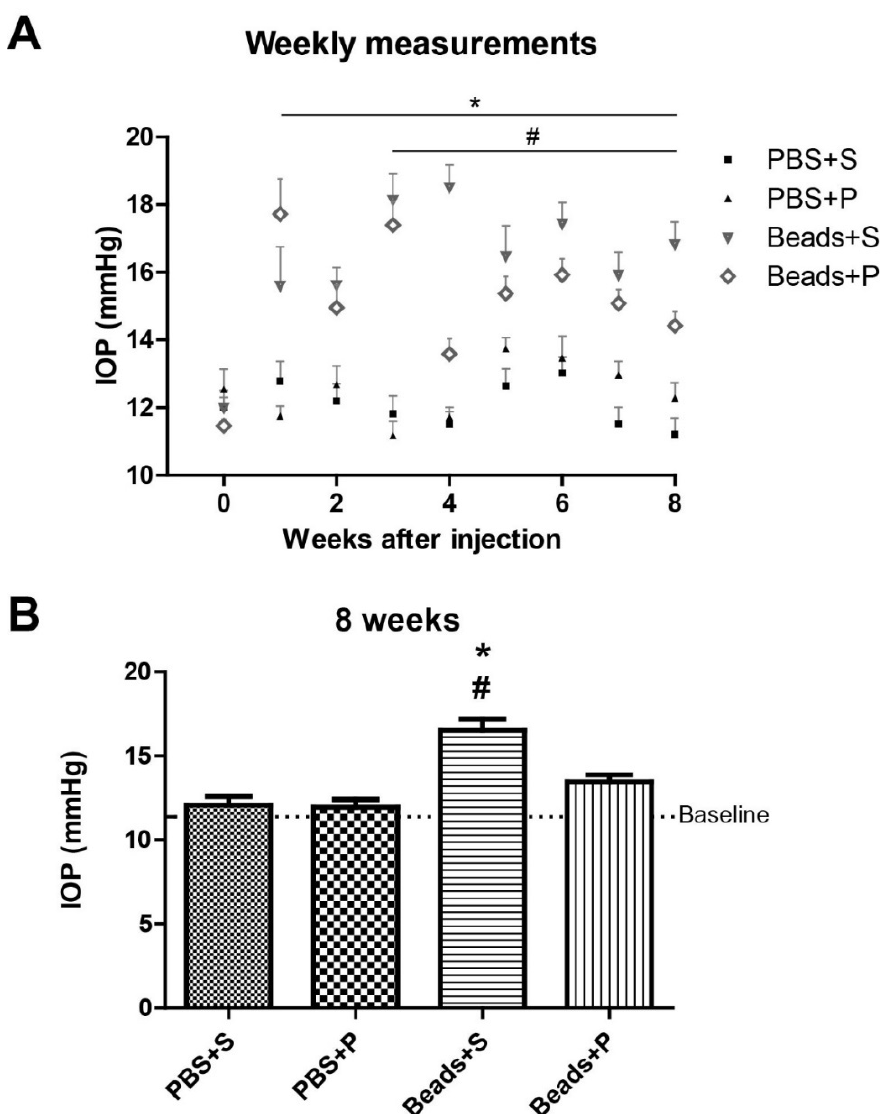
Figure 1. ( A ). IOP dynamics in the four examined groups (PBS + S, PBS + P, Beads + S, Beads + P) during the 8-week period. Intraocularly injected microbeads caused significant elevation of the IOP. ( B ). Bar chart shows the IOP in mmHg 8 weeks after the injection. Significant elevation of IOP was found in the Beads + S group compared to the control ones. PACAP1-38 eye drops resulted in the reduction of the IOP in the Beads + P group compared to the vehicle-injected group (Beads + S). Values are expressed in mean + SEM, analyzed by ANOVA and Bonferroni’s post hoc test. * Beads + S vs. PBS + S p < 0.05; # Beads + S vs. Beads + P p < 0.05. (Abbreviations: IOP: intraocular pressure; PBS: phosphate-buffered saline; S: Systane; P: PACAP1-38) .